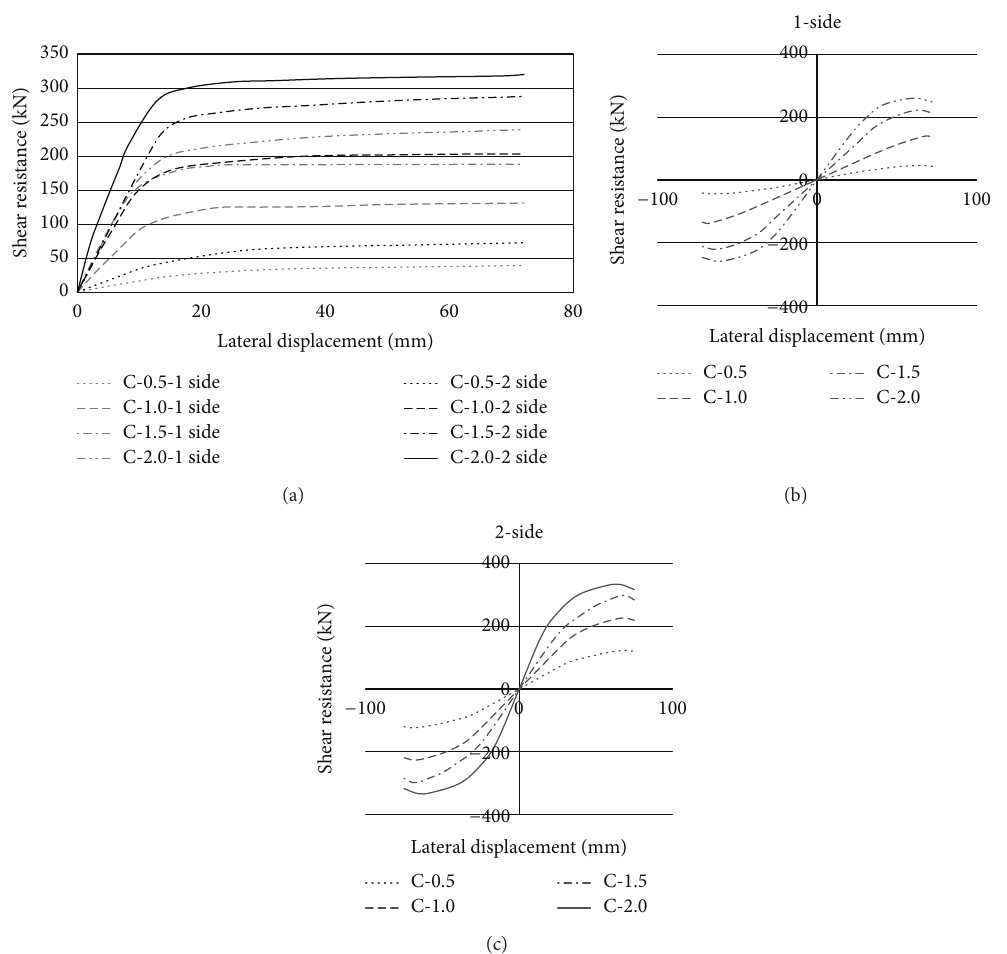
with lateral and bilateral braces and 109.33% and 174.84%, respectively, under cyclic loading. These values show that specimens B with lateral and bilateral braces could get the expected nominal design shear resistance well (Figure